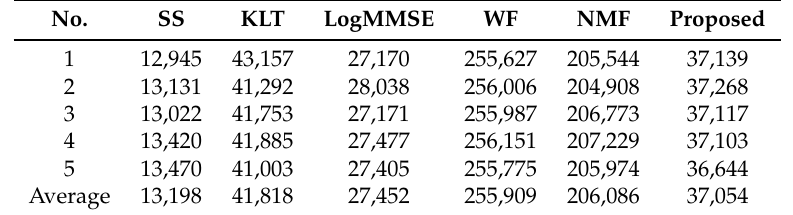
Table 4. Computational complexity of the proposed method in comparison with other methods.